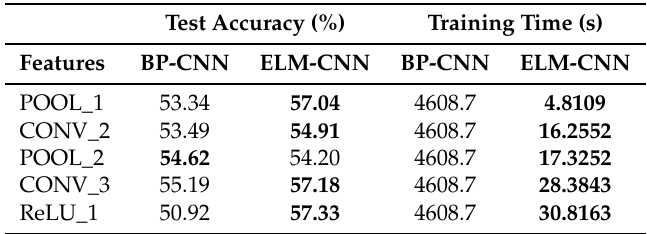
Table 2. Features performance comparison between ELM-CNN and BP-CNN on the VAIS dataset (Large Network).